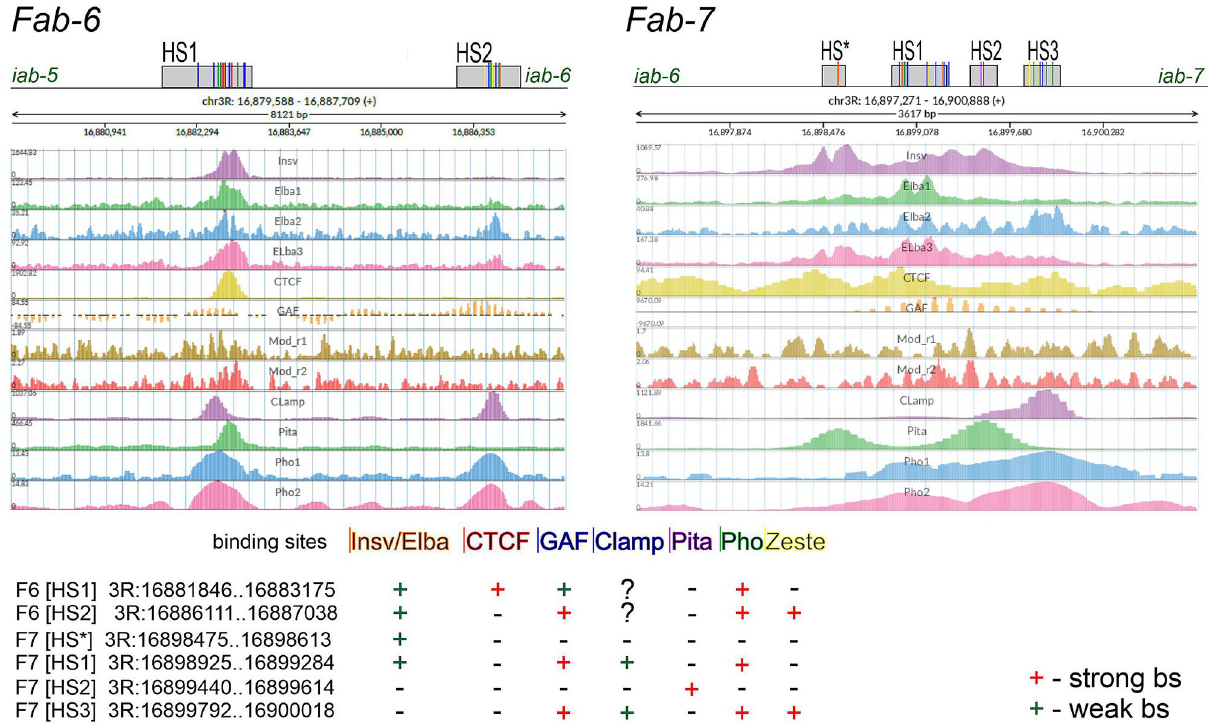
Figure 5. Comparison of chromatin protein binding to the Fab-6 and Fab-7 regions. The data are from a public functional genomics data repository GEO. The DNAse I hypersensitive sites (HS) of Fab-6 and Fab-7 are indicated as grey boxes. Binding sites for GAF, Clamp, INSV/ELBA complex, PHO, Zeste, Pita, dCTCF are indicated by short lines that correspond to the color of the protein